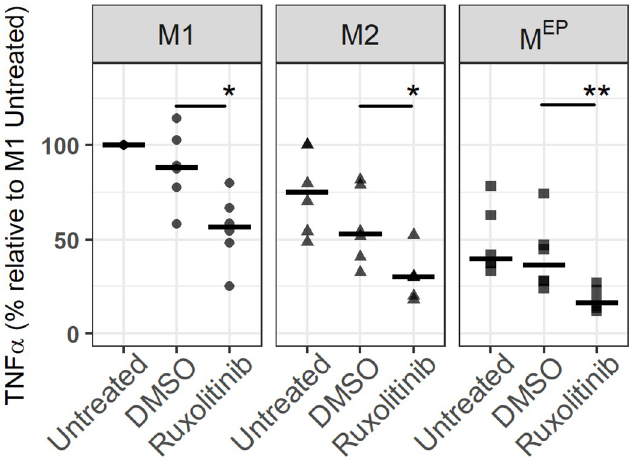
Fig 7. Effect of JAK inhibition on TNF α expression measured after infection. For each donor, data was expressed relative to the expression level in the untreated M1 macrophages from the same donor. 100% represents a median of 87 ng/mL TNF α . Lines represent the median of 6 BR. Significance is determined relative to the DMSO control for each polarization state as calculated by Wilcox test, with p-values indicated as � ( < 0.05), �� ( < 0.01).